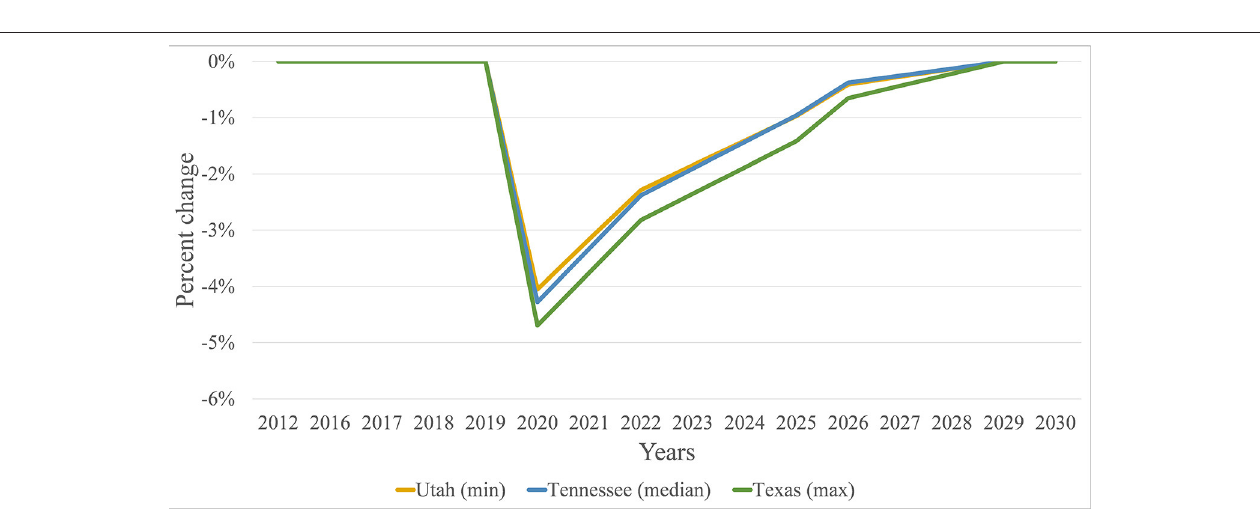
FIGURE 7 | US-FEAST state-level cow meat retail price changes in the BSE outbreak scenario compared to the baseline